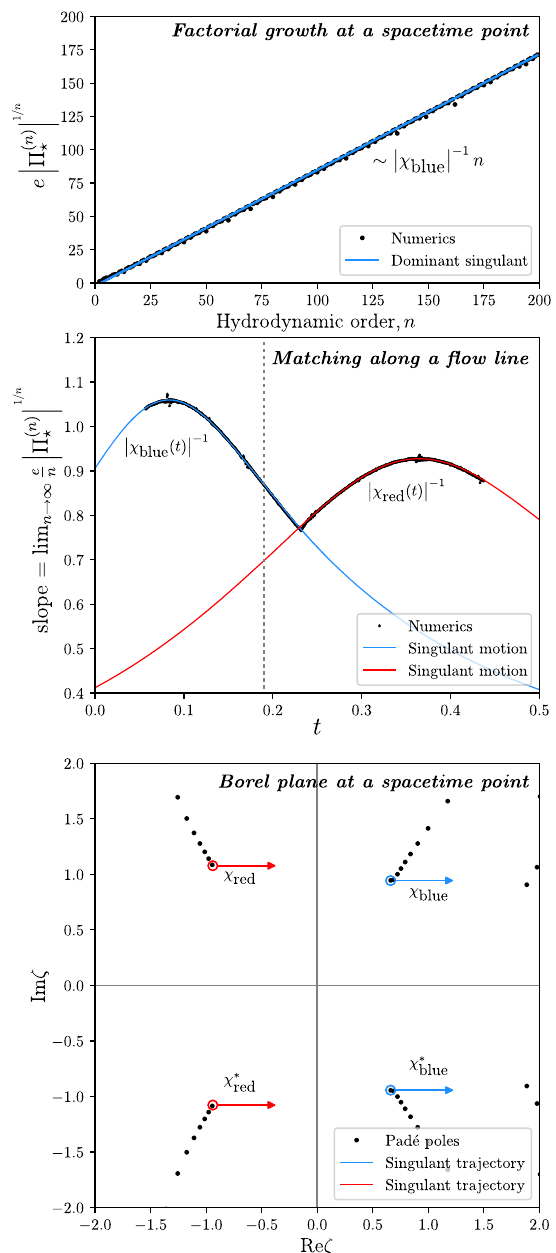
FIG. 2. Singulants in the BRSSS model for a nonlinear longitudinal flow. Top panel: root test for a numerical evaluation ð n Þ of the series Π ⋆ (black), and the slope predicted by the dominant singulant at this point χ (blue). Middle panel: fitted slope of blue the root-test plot evolving along a fluid flow line (black), with singulant predictions (red and blue). The crossing corresponds to an exchange of singulant dominance. The dashed line marks t used in the other panels. Bottom panel: singularities in the Borel plane ζ , indicated by Pad´e poles (black), illustrating agreement with singulant values (red and blue